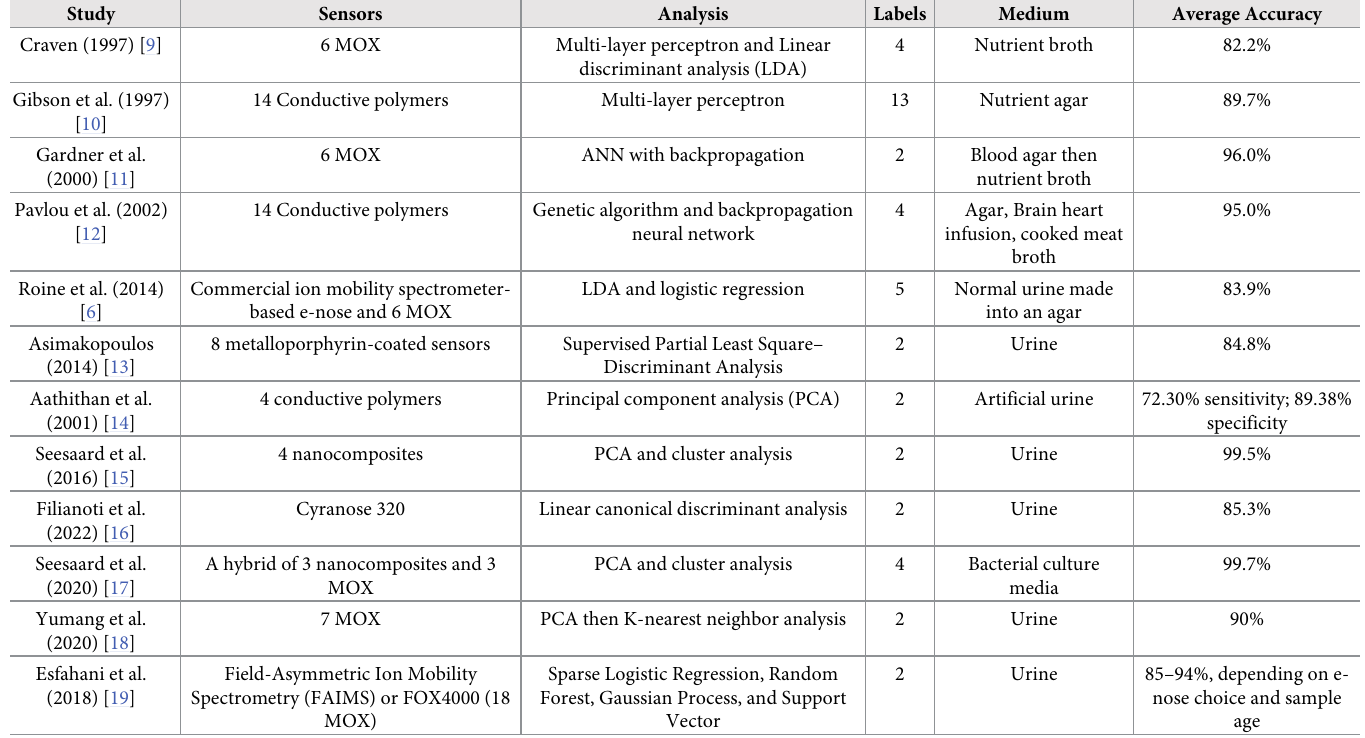
Table 1. Literature survey of sensors and classification models for e-nose